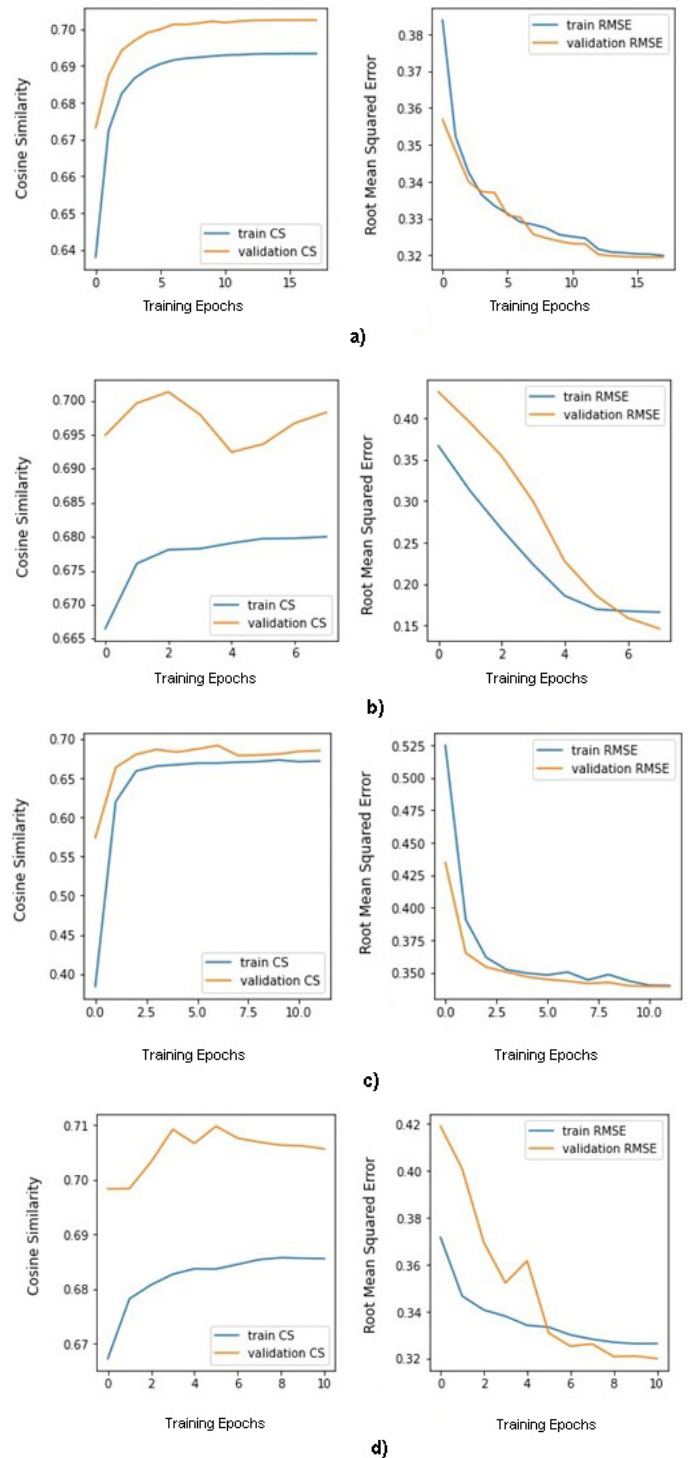
Figure 3. The values of the applied metrics during the learning process, displayed graphically: ( a ) CNN-LSTM sequence-to-sequence; ( b ) ConvLSTM sequence-to-sequence; ( c ) CNN-LSTM se- quence-to-one; ( d ) ConvLSTM